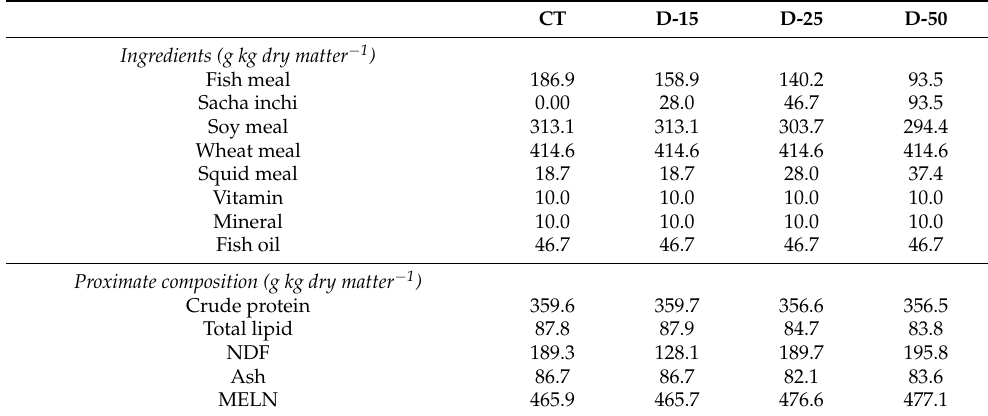
Table 2. Ingredient composition and proximate composition (g kg − 1 on dry matter basis) of the experimental